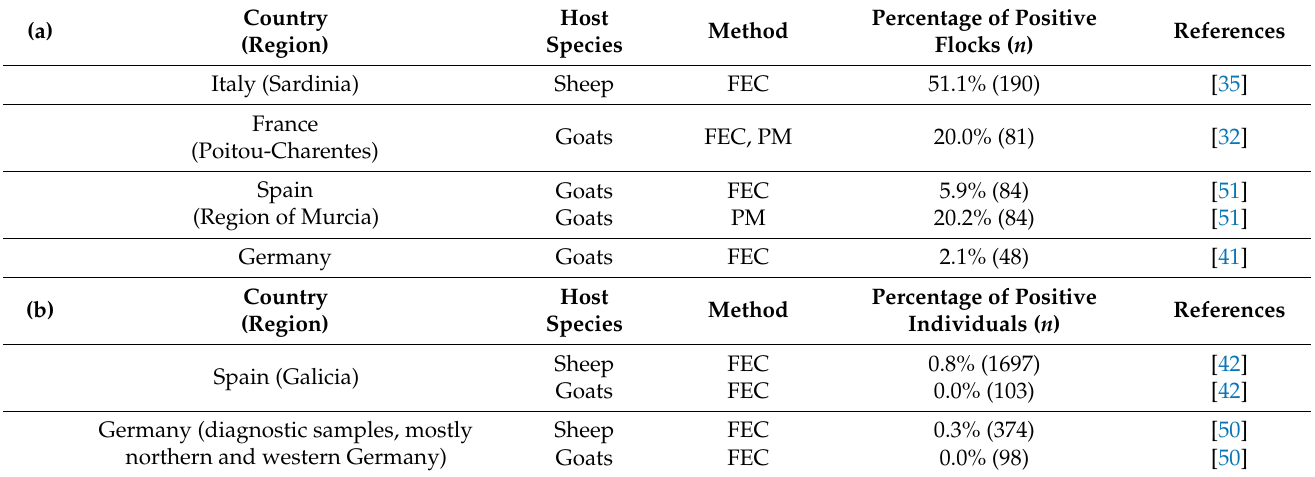
Table 3. Reported occurrence of D. dendriticum infections in small ruminants in Europe specifying the number of flocks ( a ) or number of individual animals ( b ) examined, as well as the diagnostic methods